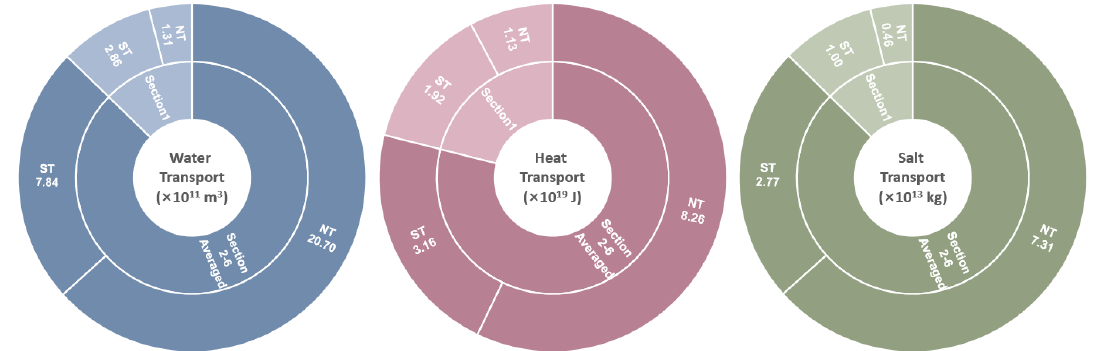
Figure 10. Spatial-temporal behavior of the hydro-thermohaline transport in the QDNS. Spring tide and neap tide are abbreviated as ST and NT, respectively.